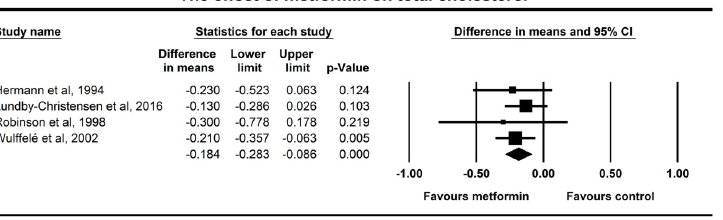
Fig 5. Forest plot analysis of total cholesterol in participants treated with metformin compared with placebo.